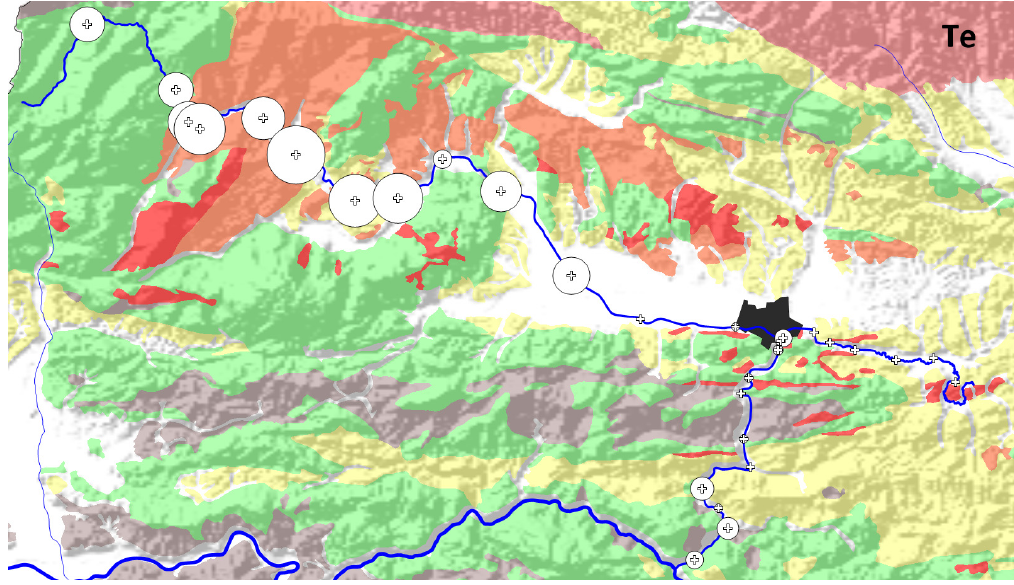
Figure 9. Te levels in stream sediments in the 0.063–0.125 mm fraction. Color coding is identical as on Figure 1.